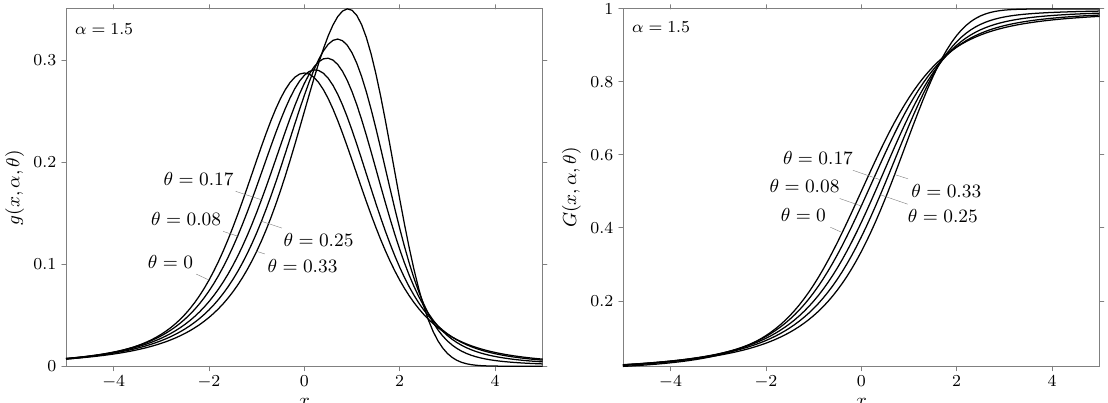
Figure 12. The probability density function g ( x , α , θ ) ( on the left ) ) and cumulative distribution function G ( x , α , θ ) ( on the right ) of a standard strictly stable law with α = 1.2 and specified values θ .